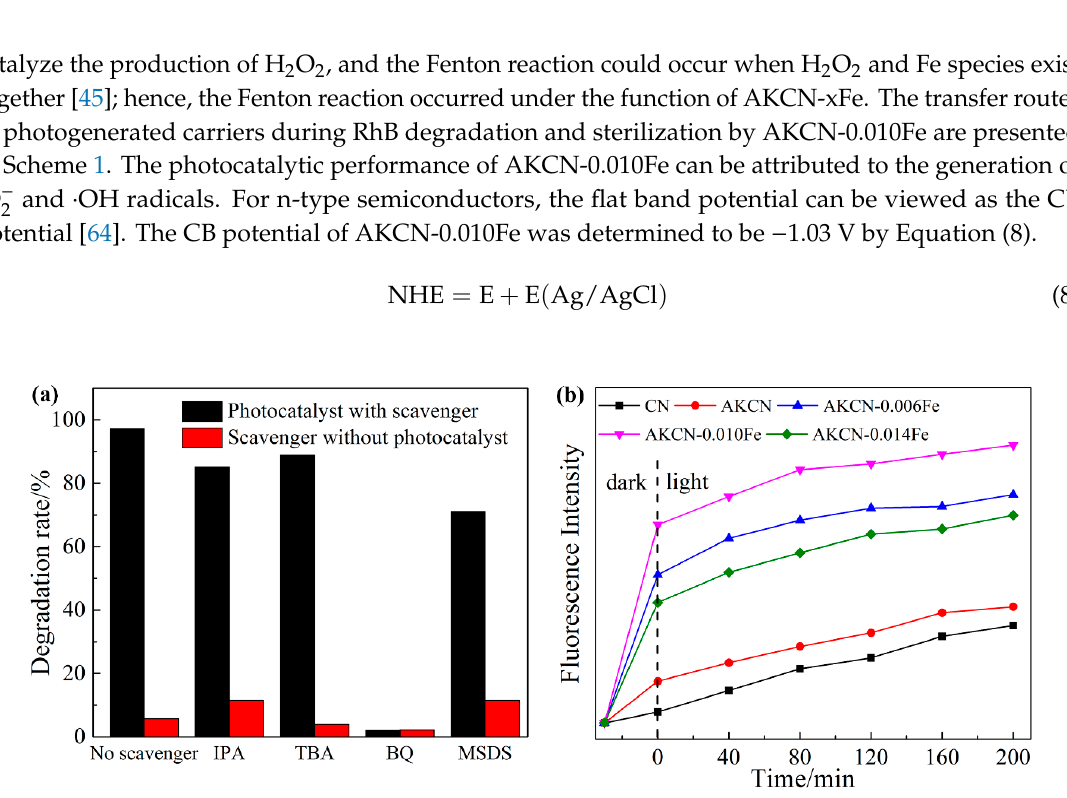
Figure 9. ( a ) Radical scavenger experiments for the degradation of RhB with AKCN-0.010Fe under visible light and ( b ) hydroxyl radicals trapping fluorescence (PL) spectra in terephthalic acid solution under visible light. Nanomaterials 2020 , 10 , x FOR PEER REVIEW 13 of 17